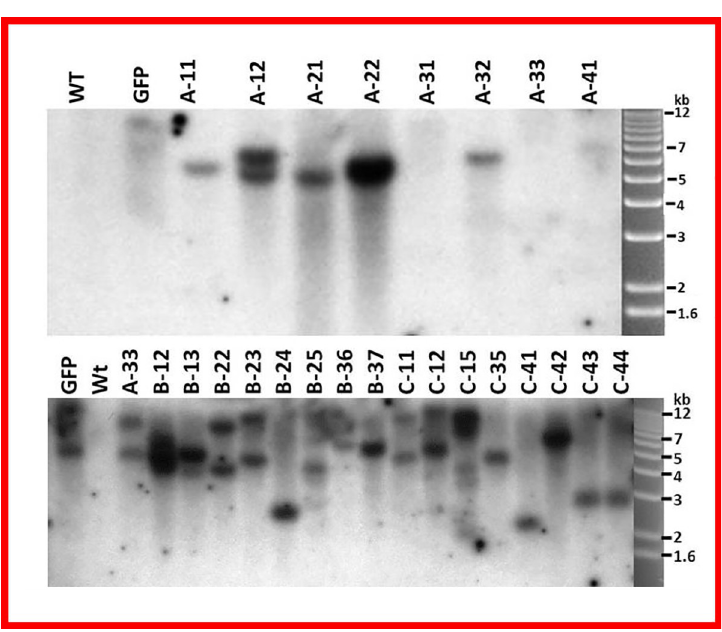
Fig 6. Southern blot analysis of T0 transgenic plants derived from wild type, gfp gene containing transgenic plants and twenty five transgenic plants derived from constructs A, B and C. The genomic DNA was digested with HindIII and probed with hyg